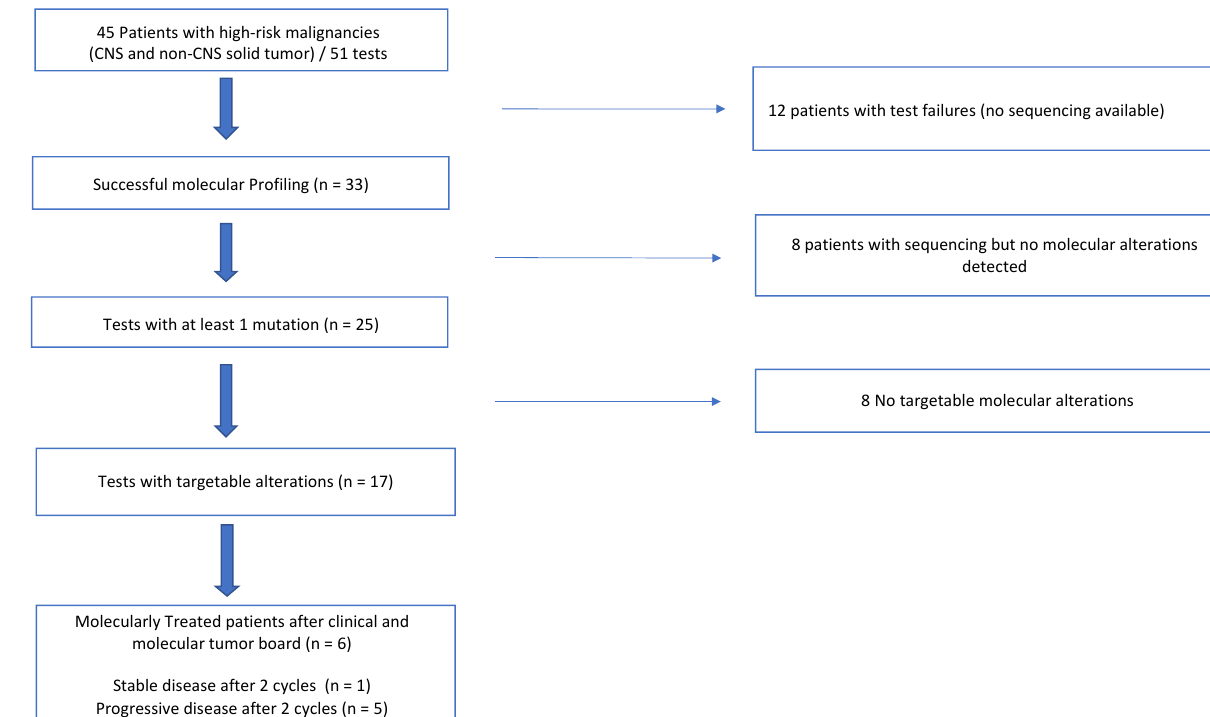
Figure 1. Flowchart of patients who underwent liquid biopsies .